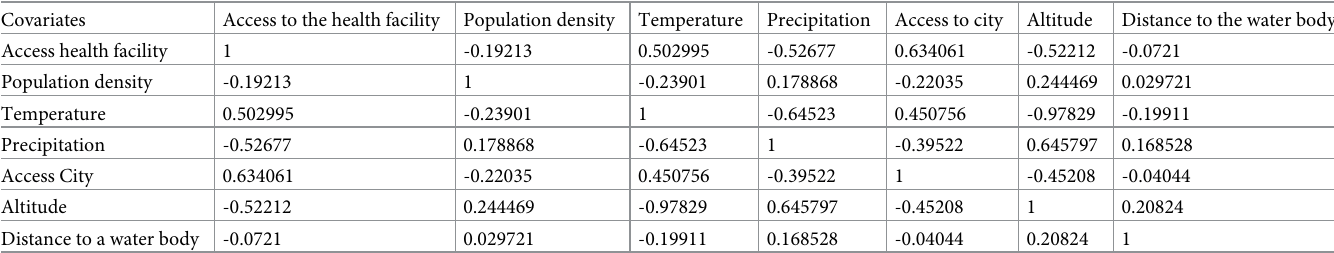
Table 1. Covariate correlation result of variables included in this